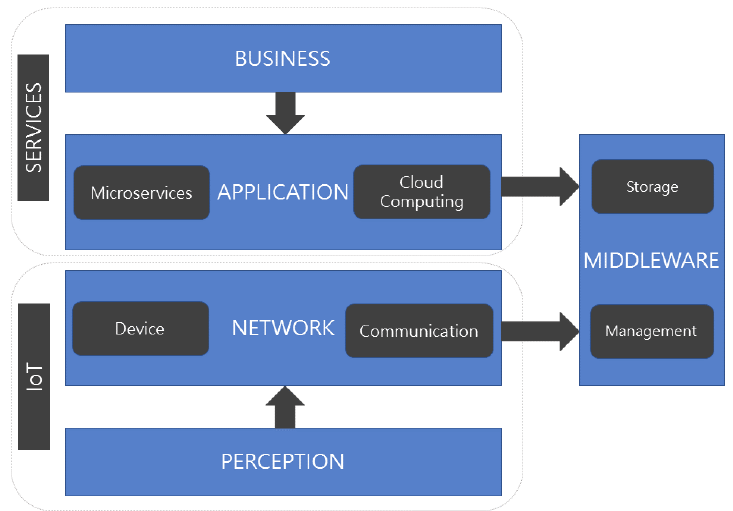
Figure 2. Abstract architecture of the proposed